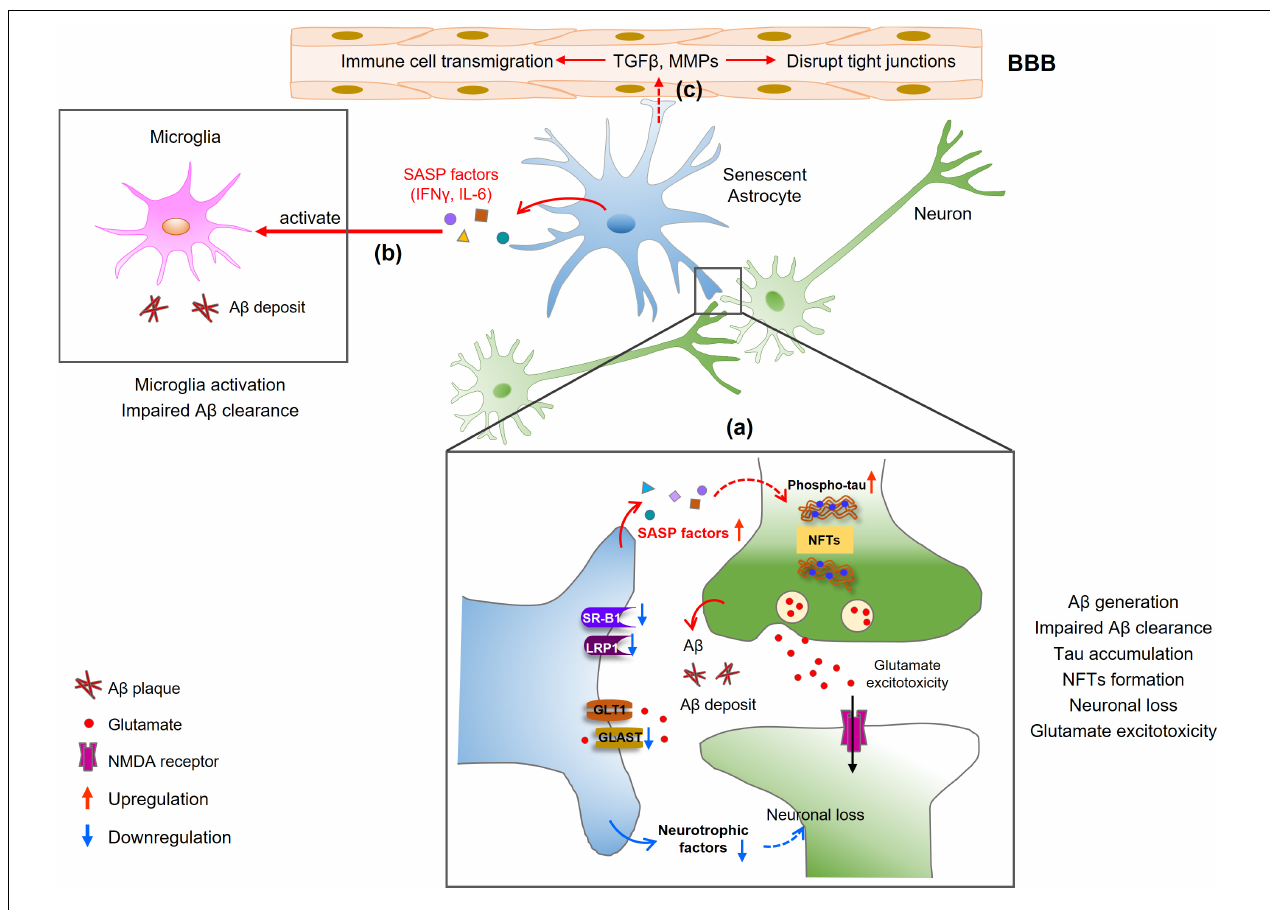
FIGURE 2 | Mechanisms of senescent astrocytes in the pathologies of AD. (a) SASP factors produced by senescent astrocytes induce A β generation and tau hyperphosphorylation, contributing to A β deposition and NFTs formation. Neurons release glutamate, which cannot be cleared from the synapse by senescent astrocytes, leading to an accumulation of extracellular excitotoxic glutamate. The reduced secretion of neurotrophic growth factors (NGF, IGF-1) in senescent astrocytes may lead to decreased neuronal growth or increased neuronal loss. (b) Senescent astrocytes secrete IFN γ and IL-6, which activate microglia and limit A β uptake by microglia. (c) SASP factors also disrupt endothelial tight junctions and induce leukocyte transmigration, resulting in BBB